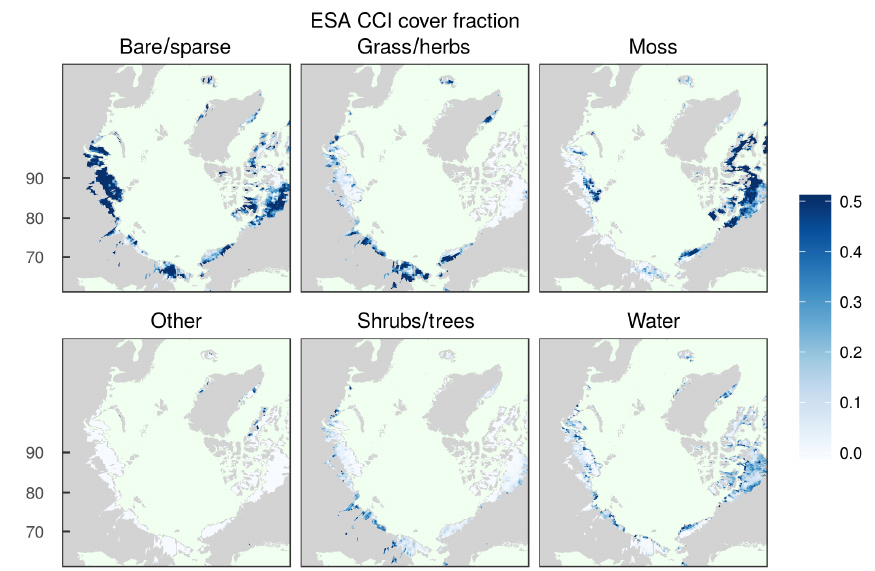
Figure A1. Fractions of the aggregated land-cover classes for the ESA CCI land-cover data set. The aggregated classes comprise “moss” (class 100 in the ESA CCI classification), “bare/sparse” (classes 28–30, 35–37, fractions of 16 and 19), “grass/herbaceous” (classes 26, fractions of 13, 16, 19, 21–25, 33), “woody” (shrubs and trees, classes 10–12, 14, 15, 17, 18, 20, fractions of 13, 16, 19, 21–25, 31–33), “water” (class 38, fractions of 31–33) and “other” (remaining classes and